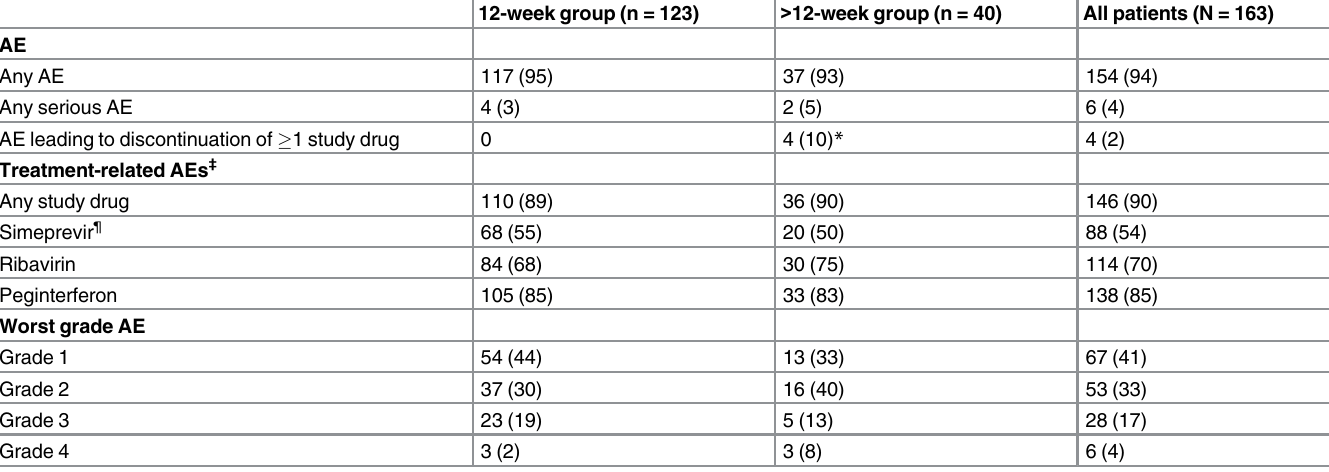
Table 2. Summary of patients experiencing AEs (on-treatment) during the entire treatment phase, overall and according to treatment group (12- or > 12-week treatment). 12-week group (n = 123) > 12-week group (n = 40)